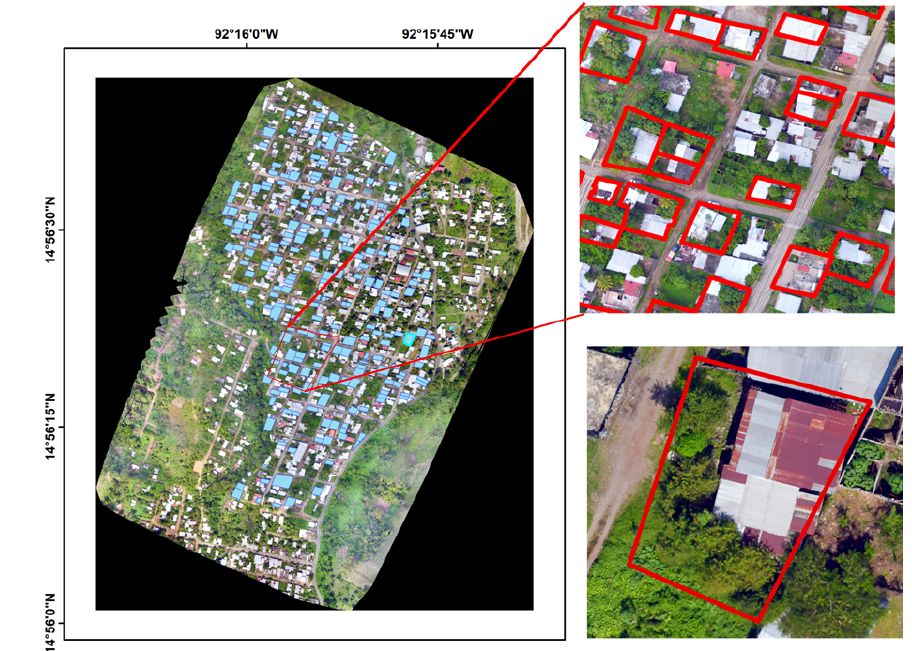
Figure 1. Orthomosaic of the El Vergel neighborhood, Tapachula, Chiapas, pointing out the houses surveyed ( left ), more resolution details for landscape elements recognition ( right